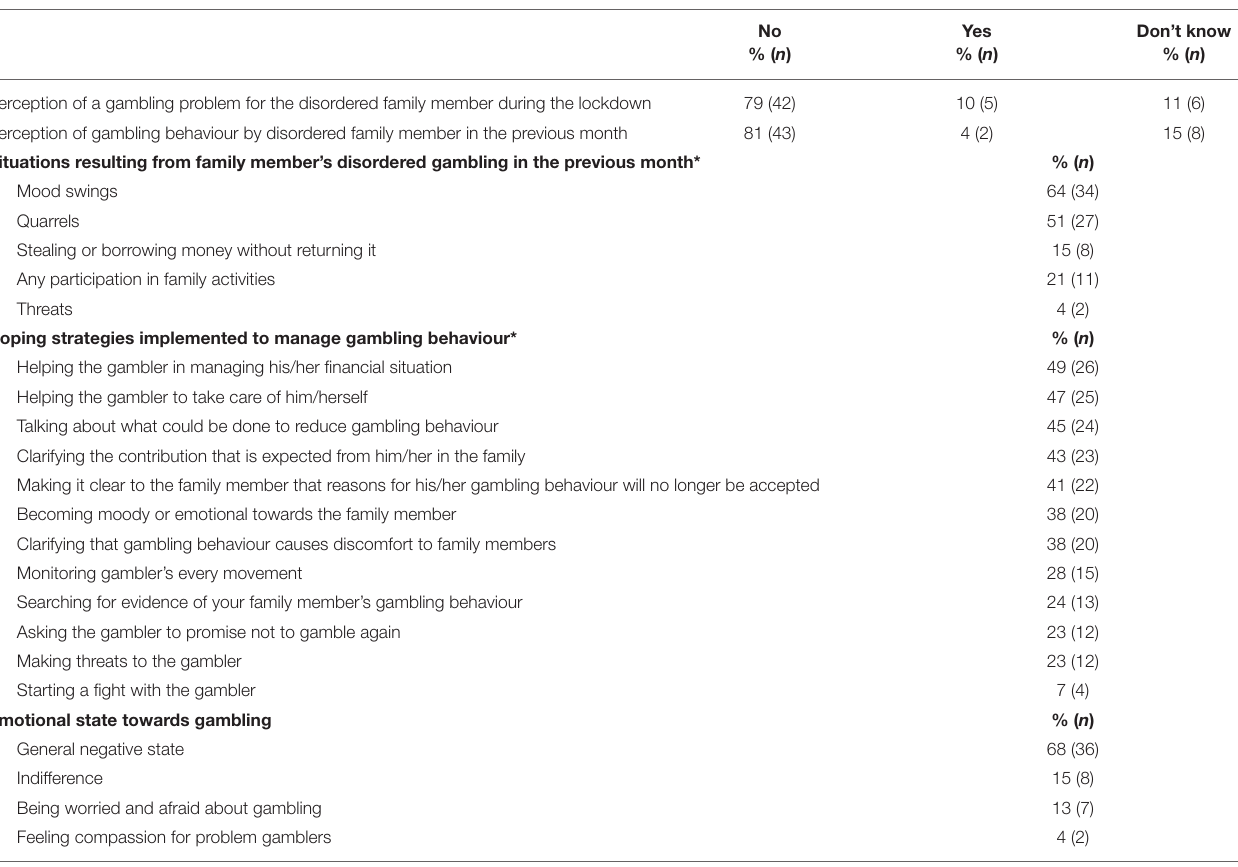
No Yes Don’t know % ( n ) % ( n ) % ( n )